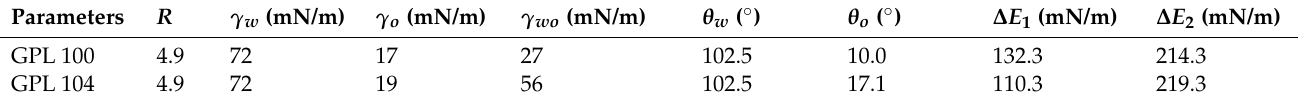
Table 2. Parameters for Equations (1) and (2).